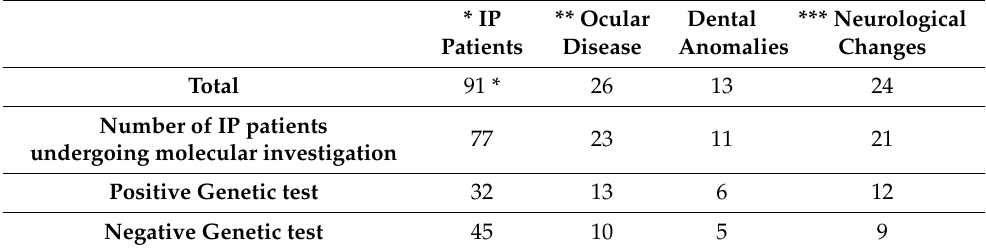
* IP ** Ocular Dental *** Neurological Patients Disease Anomalies Changes